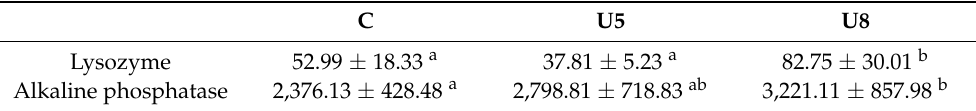
Table 5. Experiment 2. Activities of mucosal enzymes (in U/mg protein) measured in juveniles of D. labrax fed on diets including different amounts of U. ohnoi meal. Values presented as mean ± SD. Values in a row not sharing the same letter differ significantly with p <